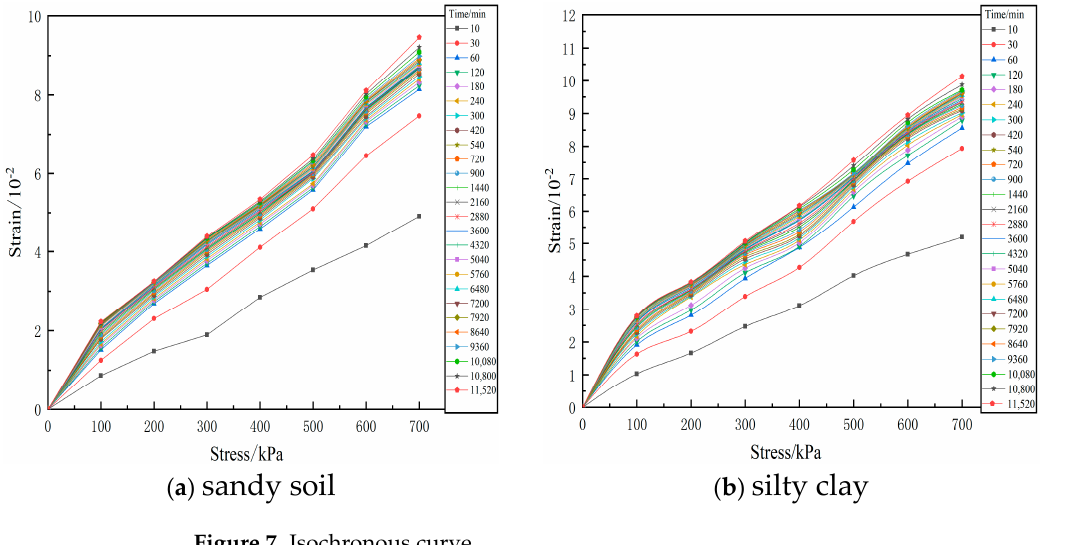
Figure 7. Isochronous curve.